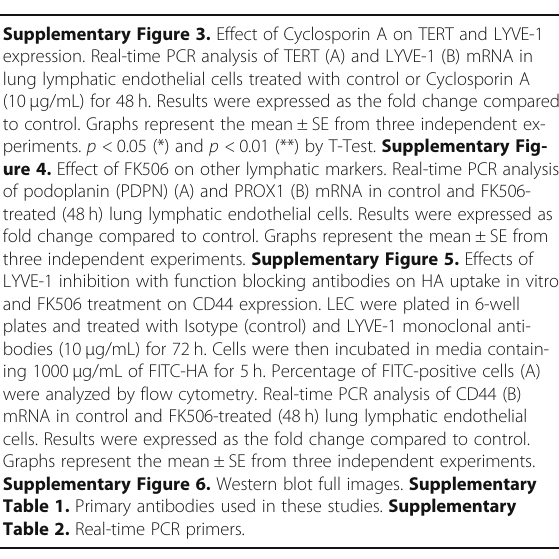
Table 2. Real-time PCR